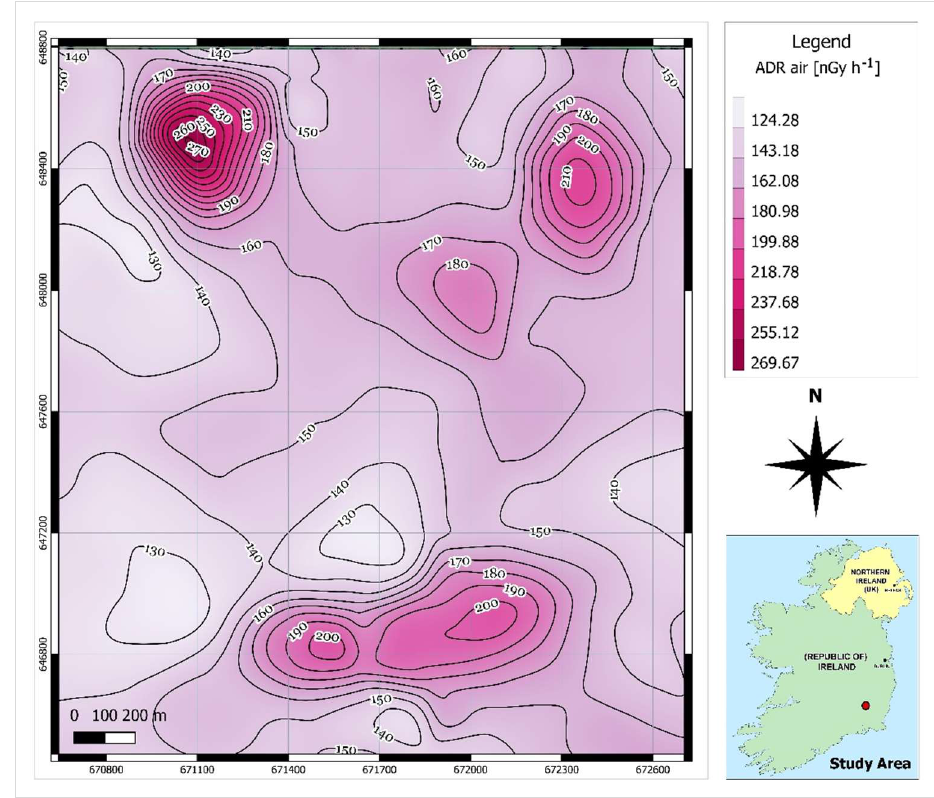
Figure 5. Contour map of air-absorbed dose rates (ADRair).